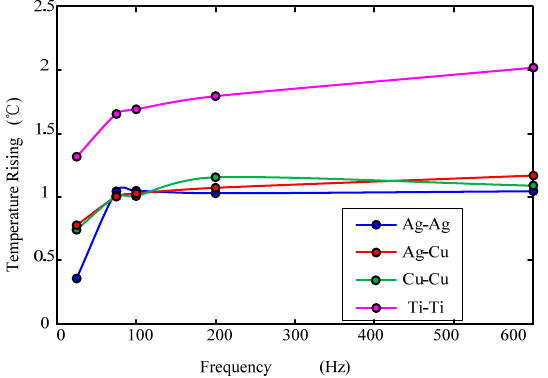
Figure 13. Temperature variations with frequency.